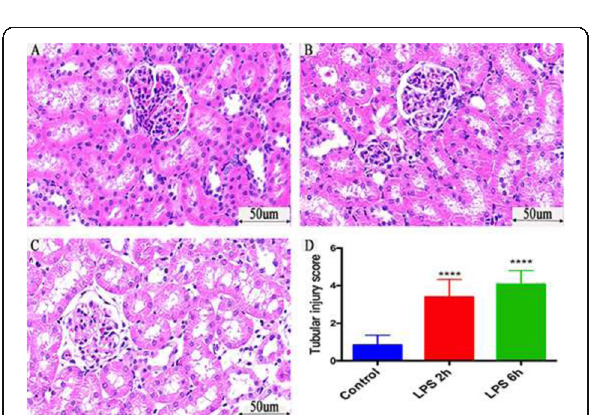
Fig. 2 (abstract 0162). Histological assessment of renal injury of PBS- or LPS-treated rats by HE-based